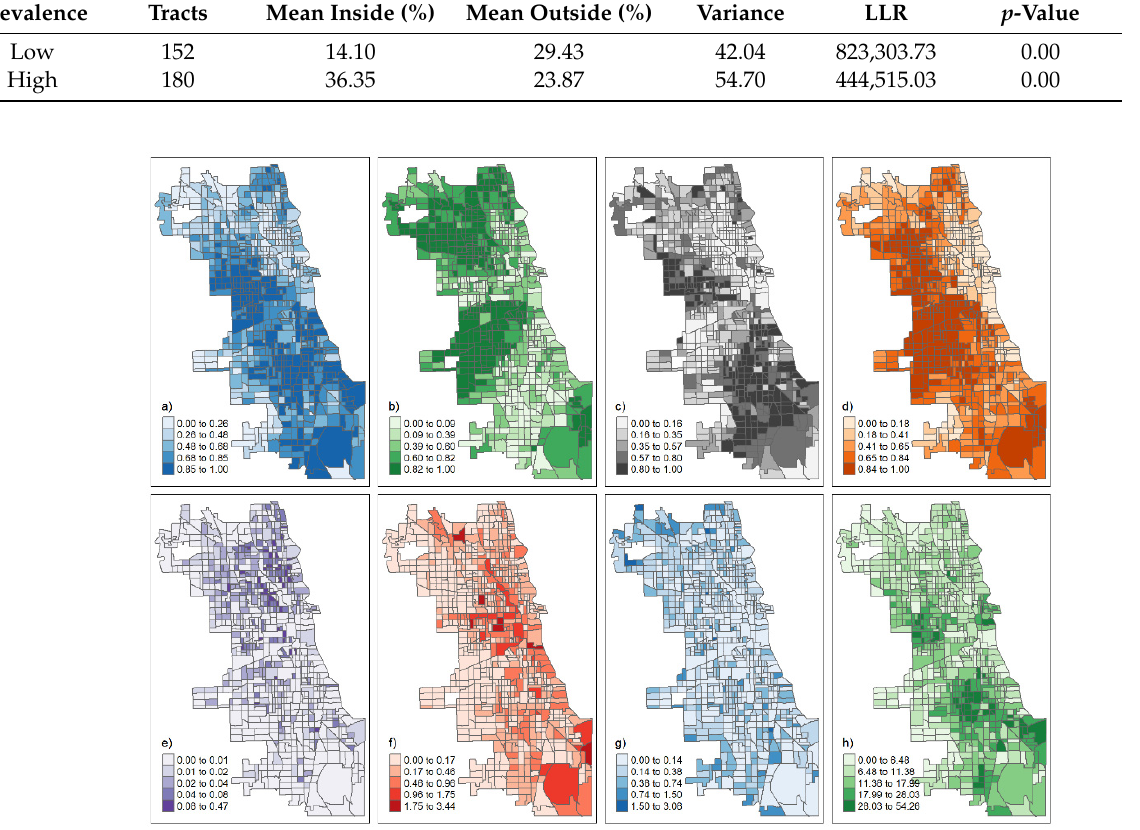
Figure 2. The spatial distribution of variables ( a ) Poverty, ( b ) Limited English, ( c ) Disabled, ( d ) No high school, ( e ) Mixed land use, ( f ) Bike ratio, ( g ) Tree ratio, ( h ) Vacant housing. Table 1. Clusters of elevated physical activity.